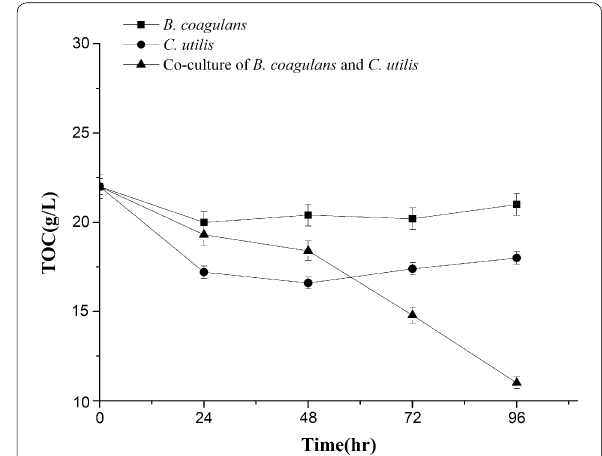
Fig. 5 Removal of TOC by B. coagulans and C. utilis using LFW as medium